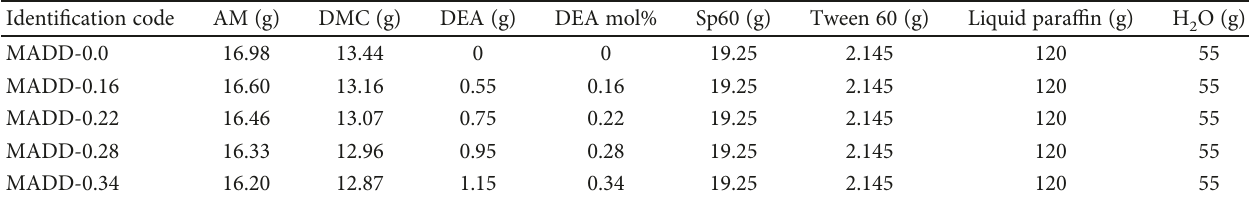
Table 3: Reaction conditions of terpolymer microspheres.